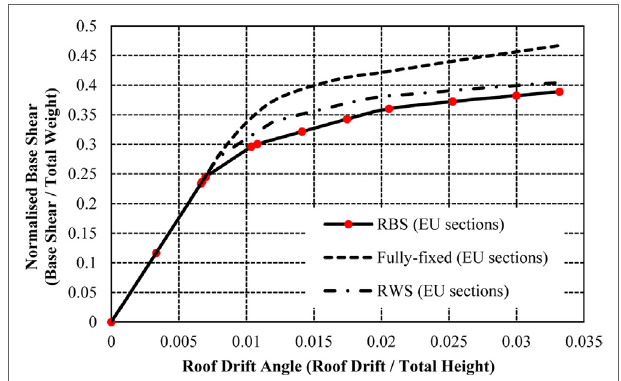
Figure 16 | Normalized capacity curves for 4-storey frame with fully fixed connections, reduced web sections (RWSs), and reduced beam sections (RBSs).